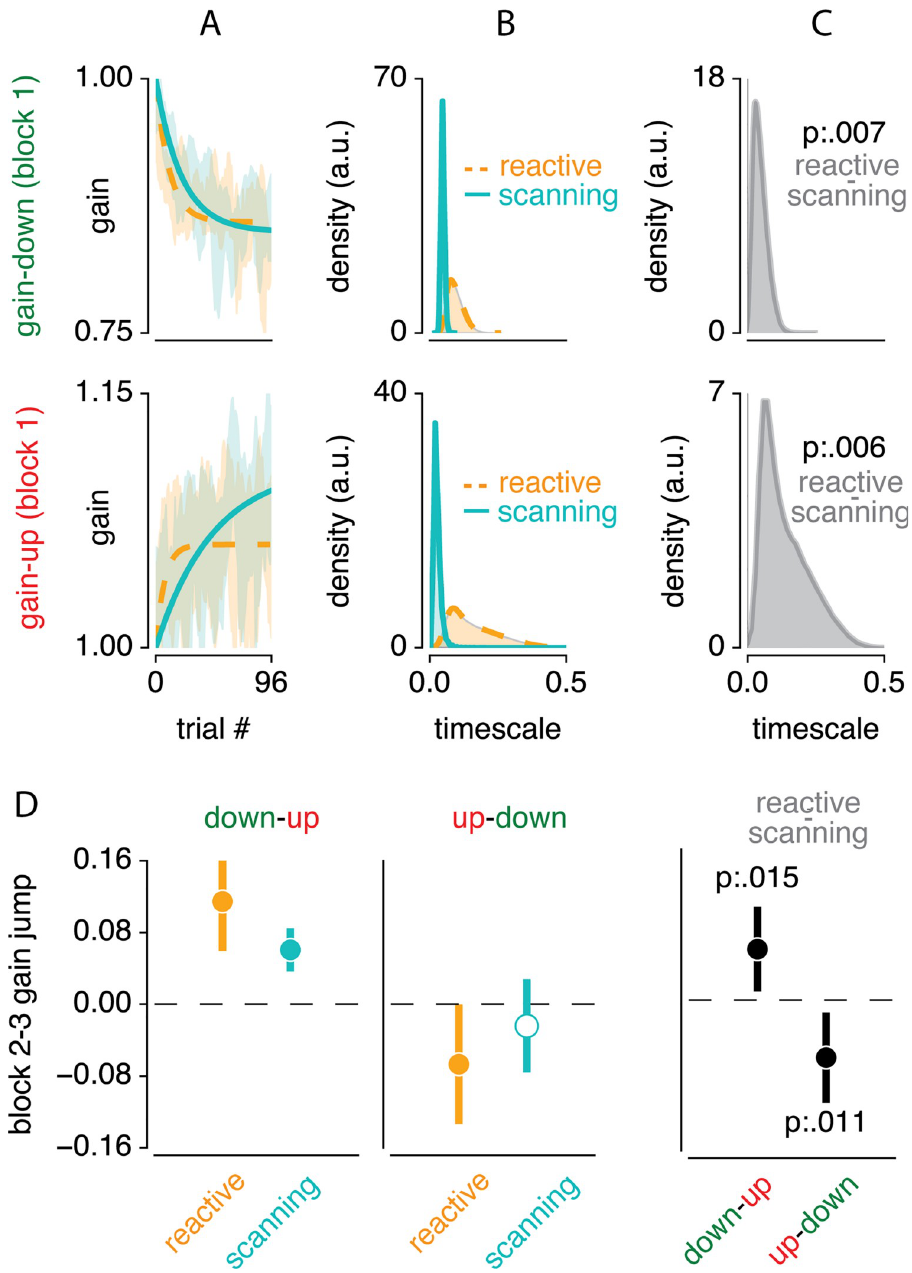
Fig 4. Indications for fast and slow process contributions. (A) Exponential functions fitted to the first adaptation block of each condition. (B) Bootstrapped distribution of the timescale parameter across participants, for the different conditions. (C) Difference in this timescale between reactive and scanning for both gain direction conditions. This shows that reactive compared to scanning saccade adaptation occurs at a faster rate. (D) Changes in saccade gain between the average of the last 6 saccades of the second block and the average of the first 6 saccades of the third block. Results are shown for both gain direction reversals (up-to-down and down-to-up) for both reactive and scanning saccades, and for the difference between these saccade types. This shows that when adapting reactive compared to scanning saccades, adaptation changes more quickly from one to another gain-change situation.